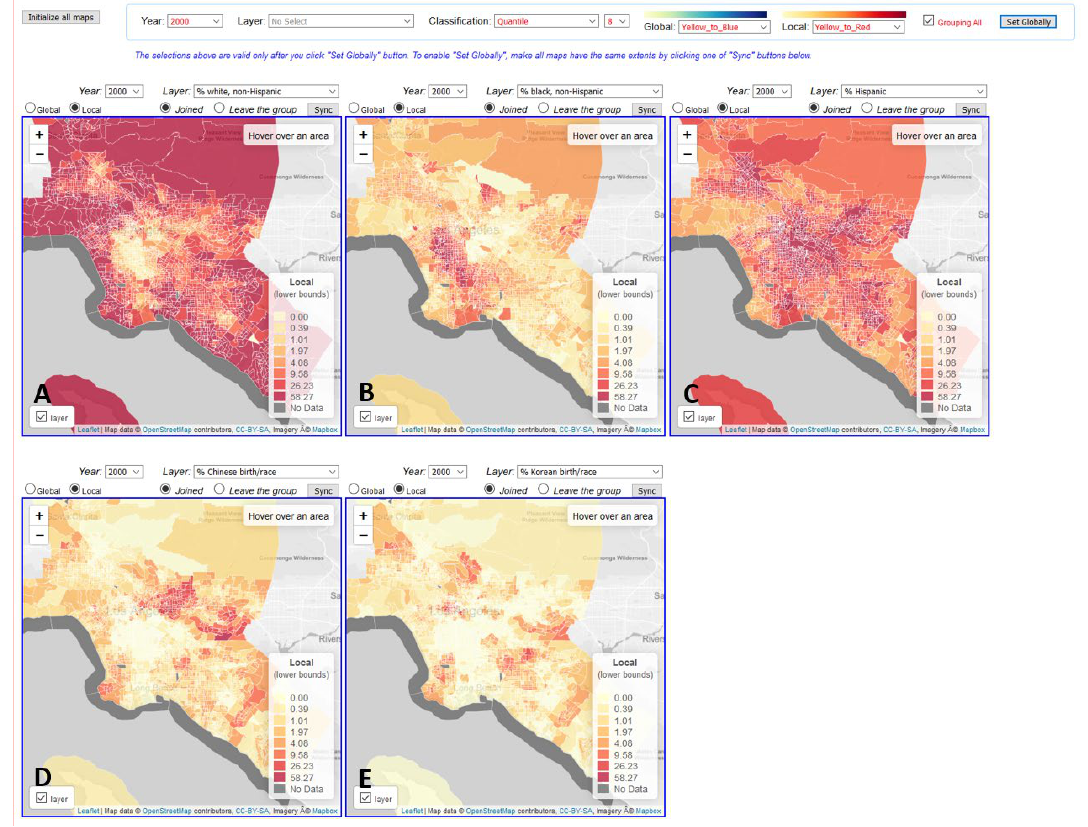
Figure 11. Linking all maps. The maps from left to right represent ( A ) percentage of whites, ( B ) percentage of blacks, ( C ) percentage of Hispanics, ( D ) percentage of Chinese, and ( E ) percentage of Koreans.